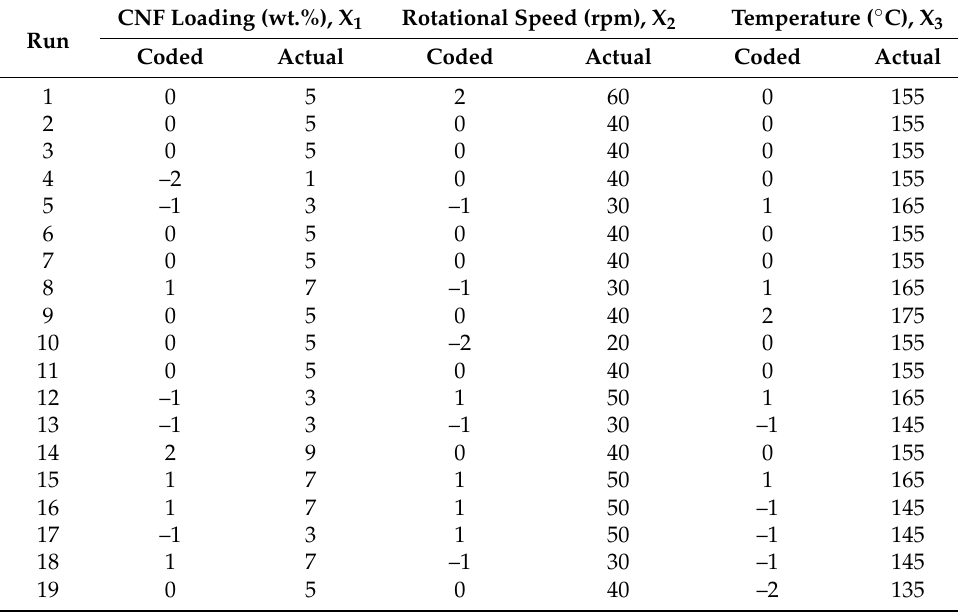
Table 1. Central composite design matrix of coded and actual factor